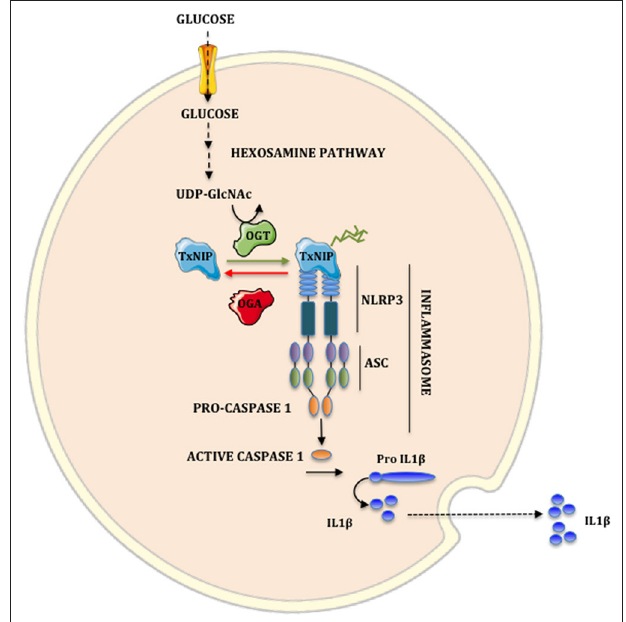
FIGURE 5 | Implication of hexosamine biosynthetic pathway on the NLRP3 inflammasome. A fraction of glucose flux is metabolized by the hexosamine biosynthetic pathway to synthesize UDP-GlcNAc. OGT uses UDP-GlcNAc to O-GlcNAcylate TxNIP. This modification increases TxNIP-NLRP3 interaction. The formation of the TxNIP-NLRP3-ASC oligomer complex activates Caspase 1. Once activated, Caspase 1 cleaves the inactive form pro-IL1 β to the biologically active form IL1 β